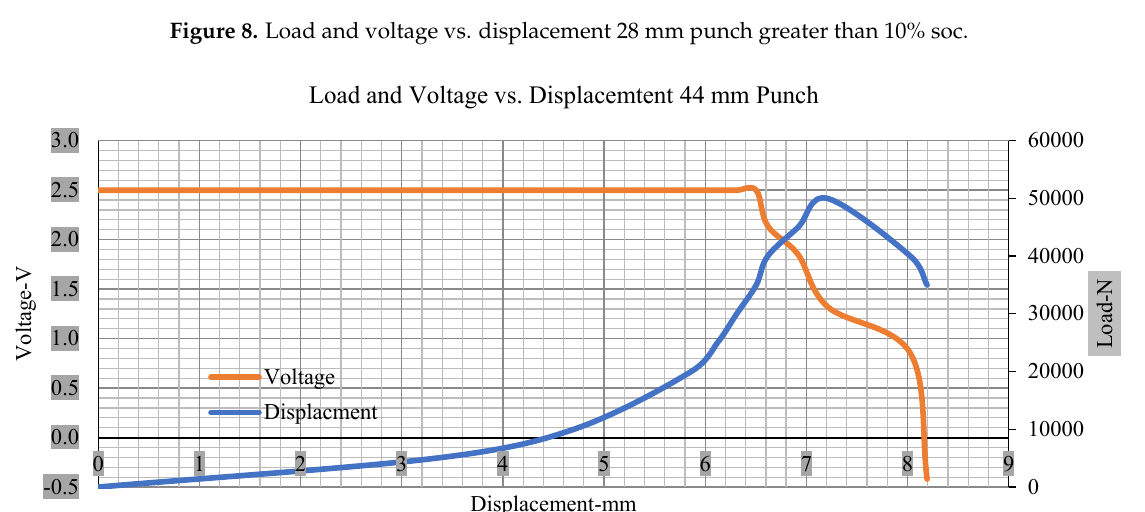
Figure 9. Load and voltage vs. displacement 44 mm punch greater than 10% soc.